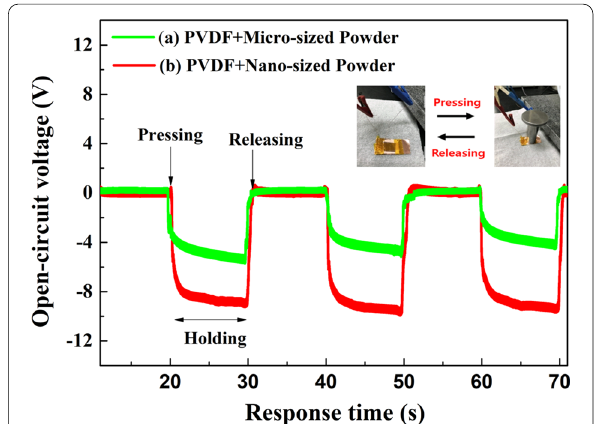
Fig. 6 Open-circuit voltage generation of PNG with PVDF and Powder during pressing and releasing conditions